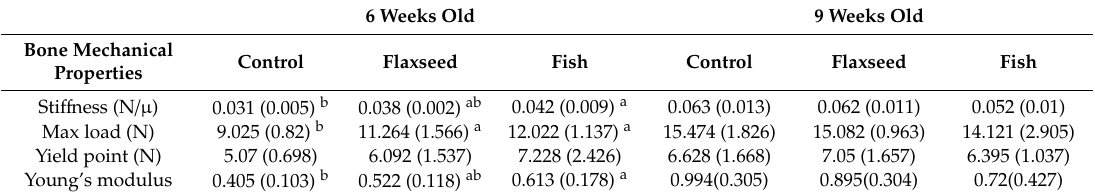
Table 6. Mechanic and morphometric characteristics of the femora in 6- and 9-week-old